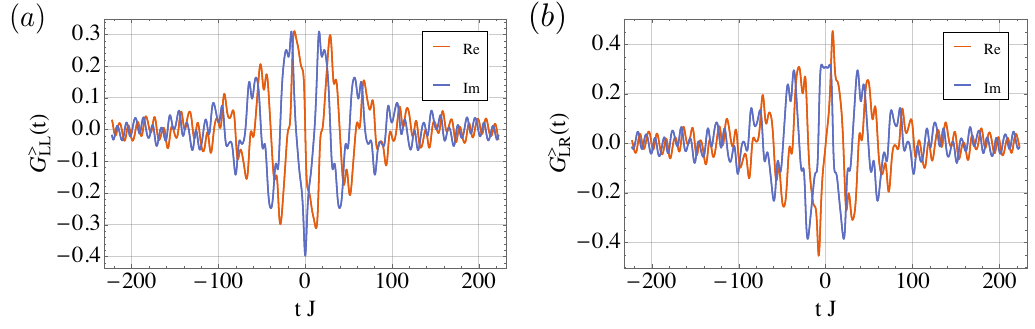
Figure 4 . The real-time Green’s functions G > ( t ) in thermal equilibrium within the wormhole phase. We choose βJ = 40 , µ c /J = 0 . 075 , µ/J = 0 . 1 and ¯ µ/J = 0